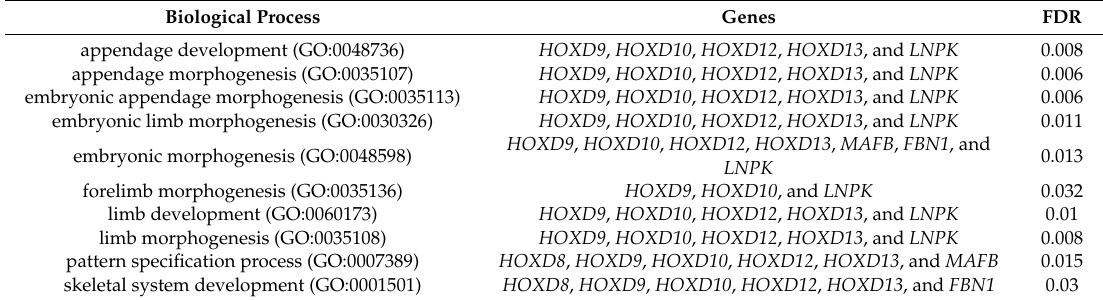
Table 1. Significant biological process under selective pressure in sport breeds.